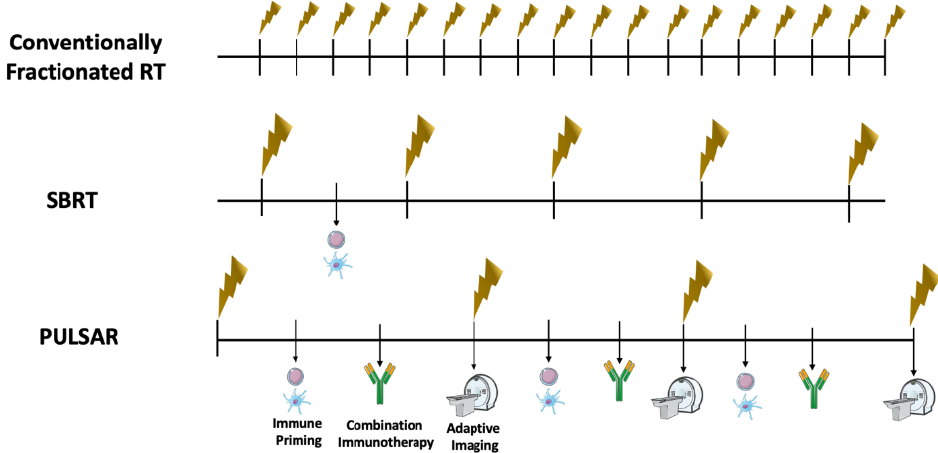
Figure 2. Potential Advantages of PULSAR Compared to Traditional Radiation Schema. Conventionally Fractionated radiation is characterized by daily treatments of non-ablative doses of radiation, that rarely lead to sufficient immune-stimulatory effects. Stereotactic Body Radiotherapy has the potential to offer ablative doses of radiation in 1 to 5 fractions, and may lead to sufficient immune priming to enhance anti-tumor immune response. However, with this approach there is no adaptation to changes in tumor anatomy between treatments, and considering a regular schedule of treatment that is typically every other day there is rarely combination with immunotherapy in between treatments. In personalized ultra-hypofractionated adaptive radiotherapy (PULSAR), pulses of ablative treatment can be delivered 2 weeks or even 1 month apart, with immune priming and immunotherapy administration regularly occurring between pulses to synergize for optimal anti-tumor effect. Furthermore, imaging prior to each pulse is acquired for personalized adaptation to tumor changes in anatomy over time.